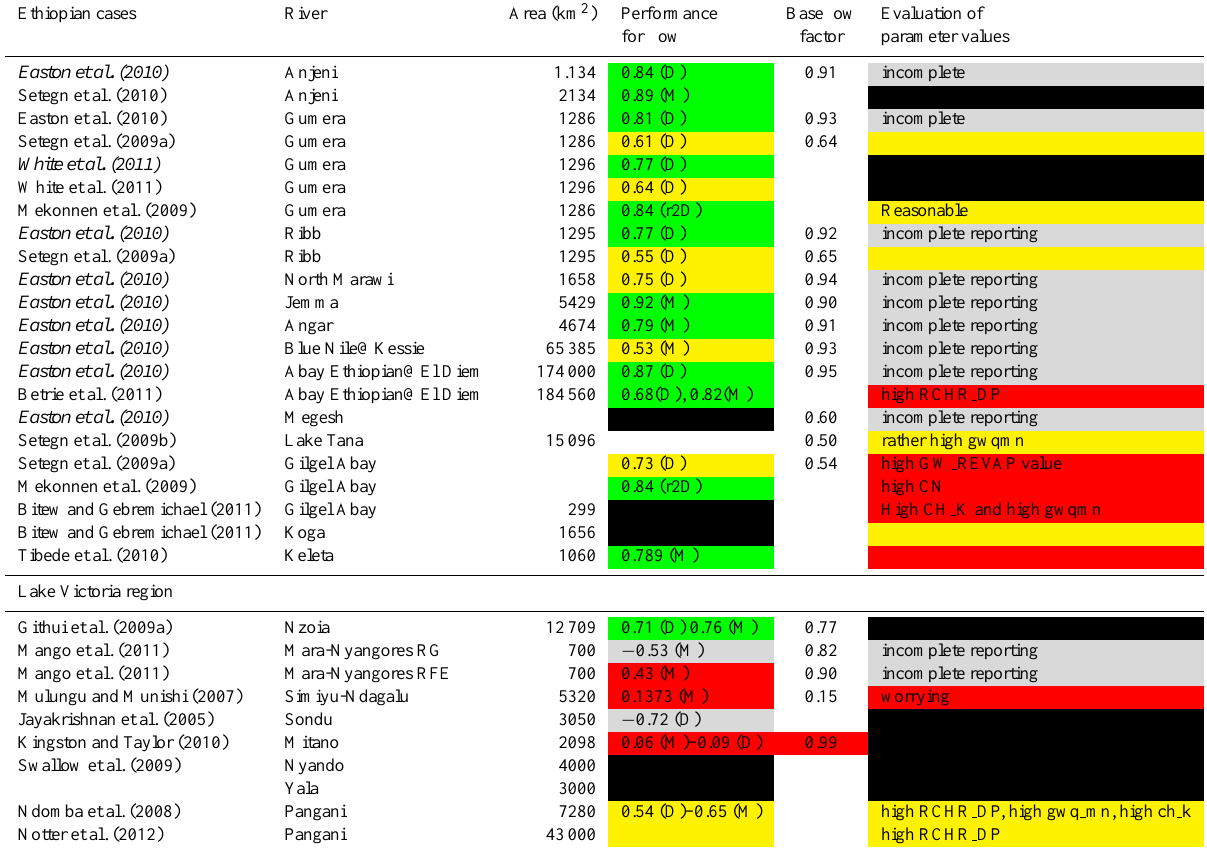
Black refers to “missing data”, grey to “incomplete data”, green to “OK”, yellow “slightly worrying”, red “worrying”. The italic papers are using SWAT-WB version. “D” refers to daily performance, “M” to monthly performance, “r2D” to the daily correlation